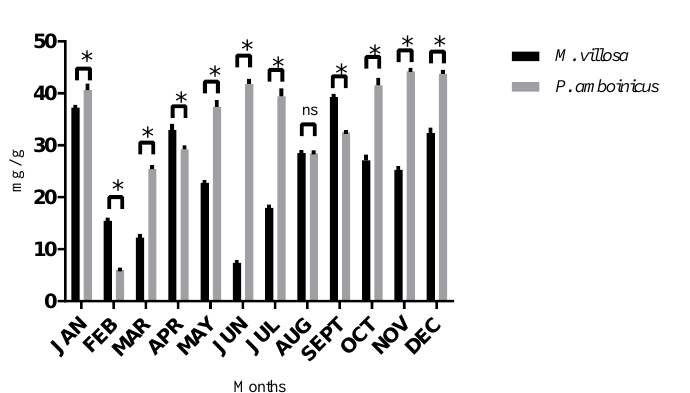
Figure 3. RA content of M. villosa and P. amboinicus extracts throughout 12 months and their statistical differences. ns = nonsignificant. * statistical difference.